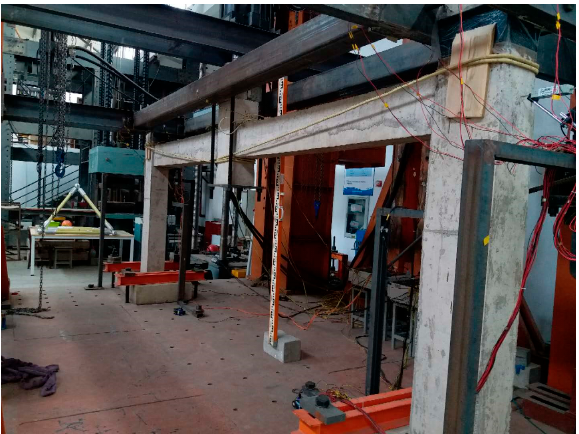
Figure 9. Specimen BCS.